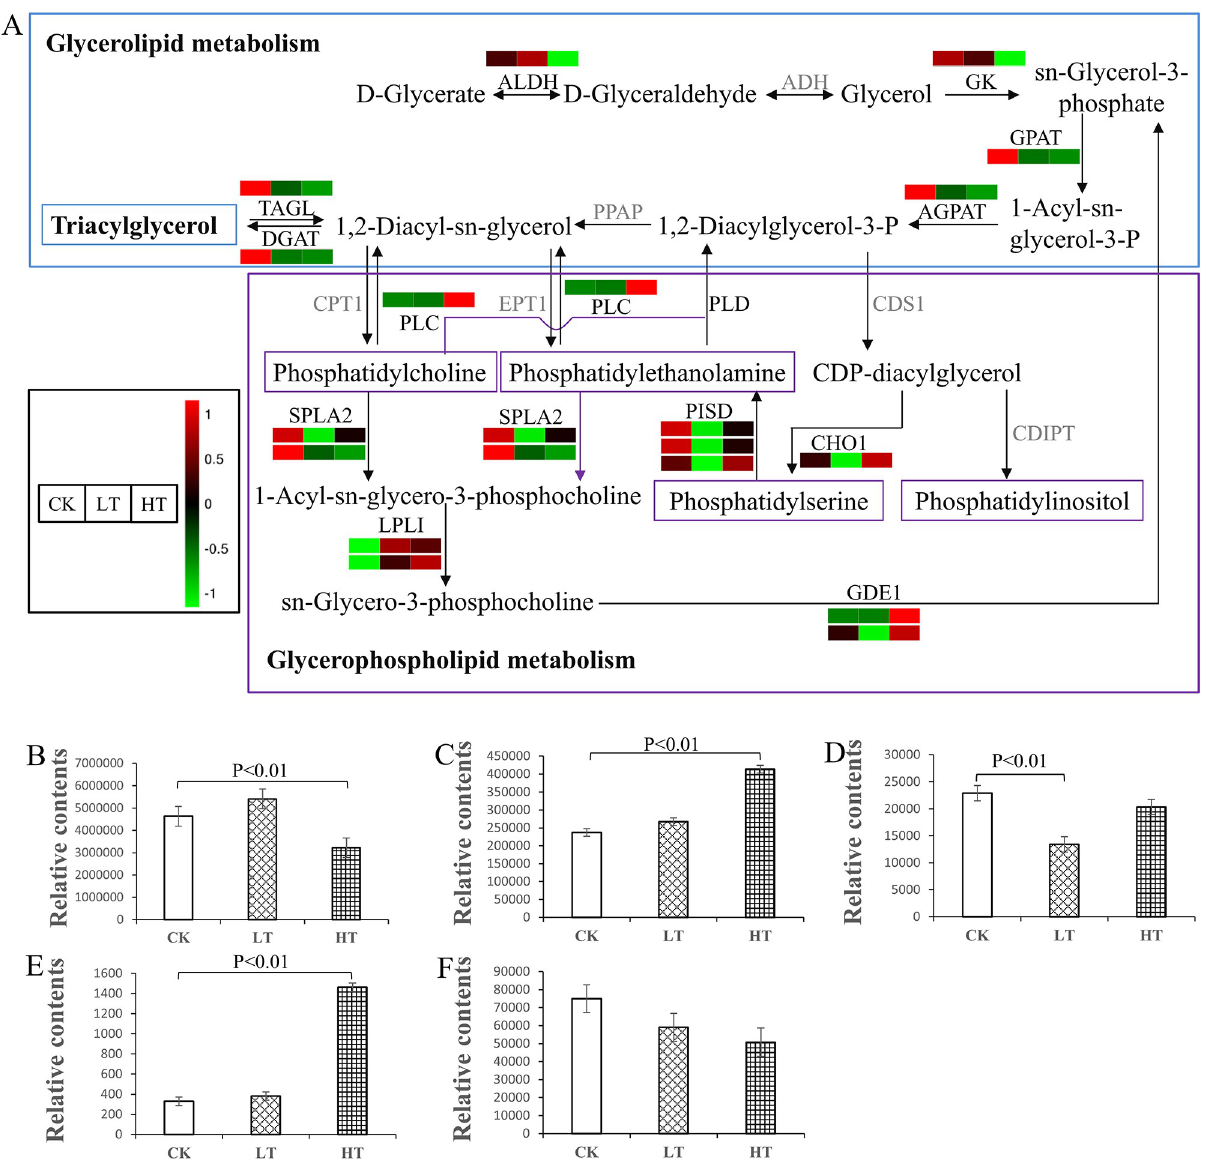
Fig 8. The KEGG pathways for glycerolipid and glycerophospholipid metabolism and the relative contents of their metabolites. (A) Key enzymes encoded by the DEGs in the glycerolipid and glycerophospholipid metabolism pathways. Red and green indicate the genes were upregulated and downregulated, respectively, while grey indicates no significant differences in the pathways. ALDH, aldehyde dehydrogenase. ADH, alcohol dehydrogenase. GK, glycerol kinase. GPAT, glycerol-3-phosphate O-acyltransferase. AGPAT, 1-acylglycerol-3-phosphate acyltransferase. PPAP, phosphatic acid phosphatase. DGAT, diacylglycerol O-acyltransferase 1. TAGL, triacylglycerol lipase. CPT1, diacylglycerol cholinephosphotransferase. EPT1, ethanolaminephosphotransferase. PLC, phospholipase C. PLD, phospholipase D. CDS1, phosphatidate cytidylyltransferase. CDIPT, CDP- diacylglycerol—inositol 3-phosphatidyltransferase. CHO1, CDP-diacylglycerol—serine O-phosphatidyltransferase. PISD, phosphatidylserine decarboxylase. SPLA2, secretory phospholipase A2. LPLI, lysophospholipase I. GDE1, glycerophosphodiester phosphodiesterase. Relative content of (B) triacylglycerol, (C) phosphatidylcholine, (D) phosphatidylethanolamine, (E) phosphatidylserine, and (F) phosphatidylinositol under low- or high- temperature stress. P < 0.01 was considered the level of statistical significance. LT, samples incubated at 22˚C. CK, samples incubated at 30˚C. HT, samples incubated at